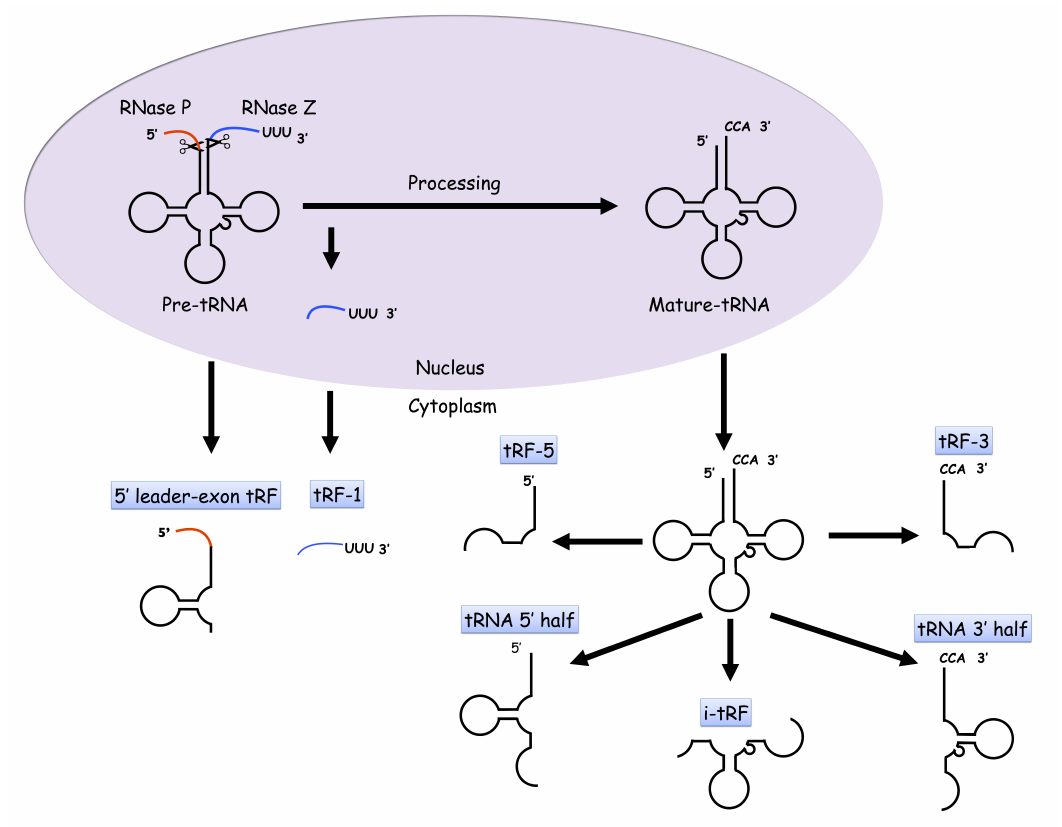
Figure 1. Biogenesis of tRNA-derived small RNAs (tDRs) . In eukaryotic cells, precursor tRNAs undergo processing and become mature tRNAs. The cleavage of precursor tRNAs generates tRNA-derived small RNA fragments (tRF-1s) and 5’ leader-exon tRFs. tRF-5s, tRF-3s, i-tRFs, 5’ halves and 3’ halves are generated by the cleavage of mature